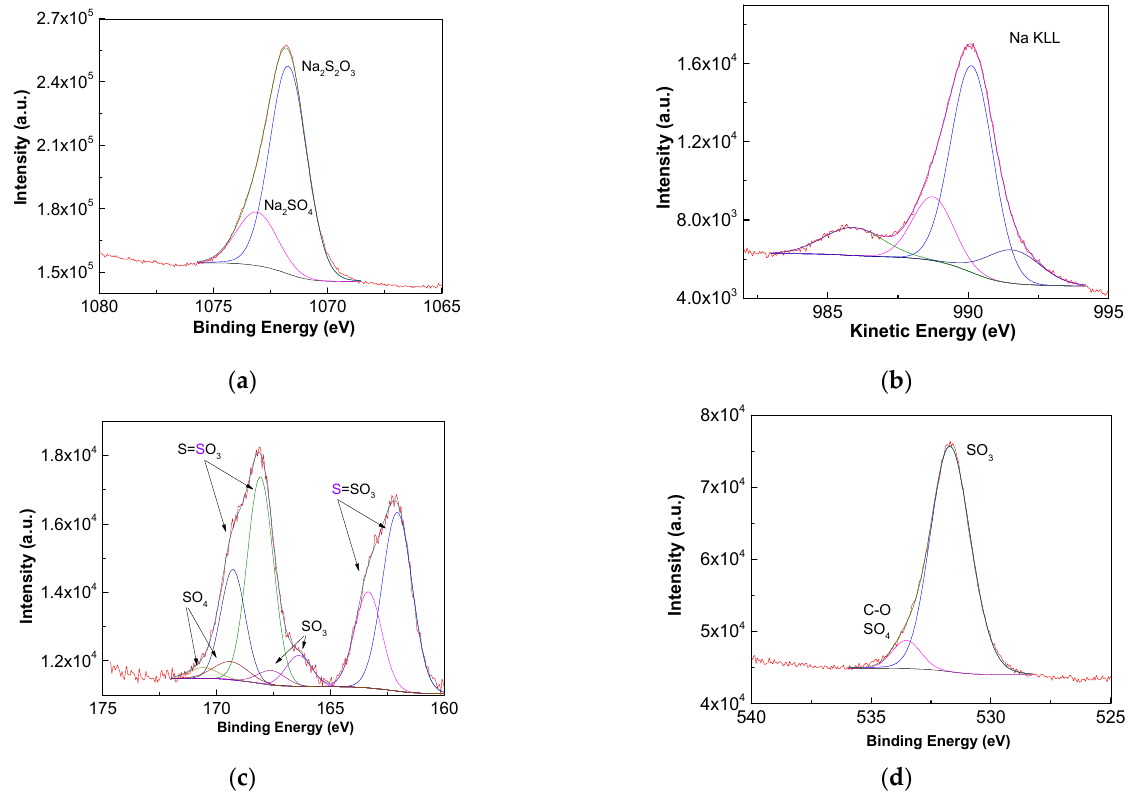
Figure 6. X-ray photoelectron spectroscopy (XPS) Na1s ( a ), S2p ( c ) and O1s ( d ) spectra of ST. Figure ( b ) shows the Na KLL Auger spectrum of ST. Figure 7a 1 ,b 1 ,c 1 ,d 1 shows: (i) an AZA XPS C1s spectrum, which, by deconvolution, leads to four bands at 284, 284.8, 285.7, and 286.4 eV, associated with the sp 2 C=C, C-C + C-H + C-S, C-N/C=N and C-O bonds [34]; (ii) an AZA XPS O1s spectrum, which shows an intense band at 532 eV accompanied by a band of low intensity at 535 eV, associated with the C-O bonds and water traces [34]; (iii) an AZA XPS N1s spectrum that shows three bands at 398.6, 400.3 and 405.3 eV associated with the C=N-C bond [34], the C 2 NH secondary amine [34,35] and the NO 2 group [36]; and (iv) an AZA XPS S2p spectrum, which highlights, by deconvolution, two bands at 163.4 and 164.6 eV coming from the thiol groups [35].